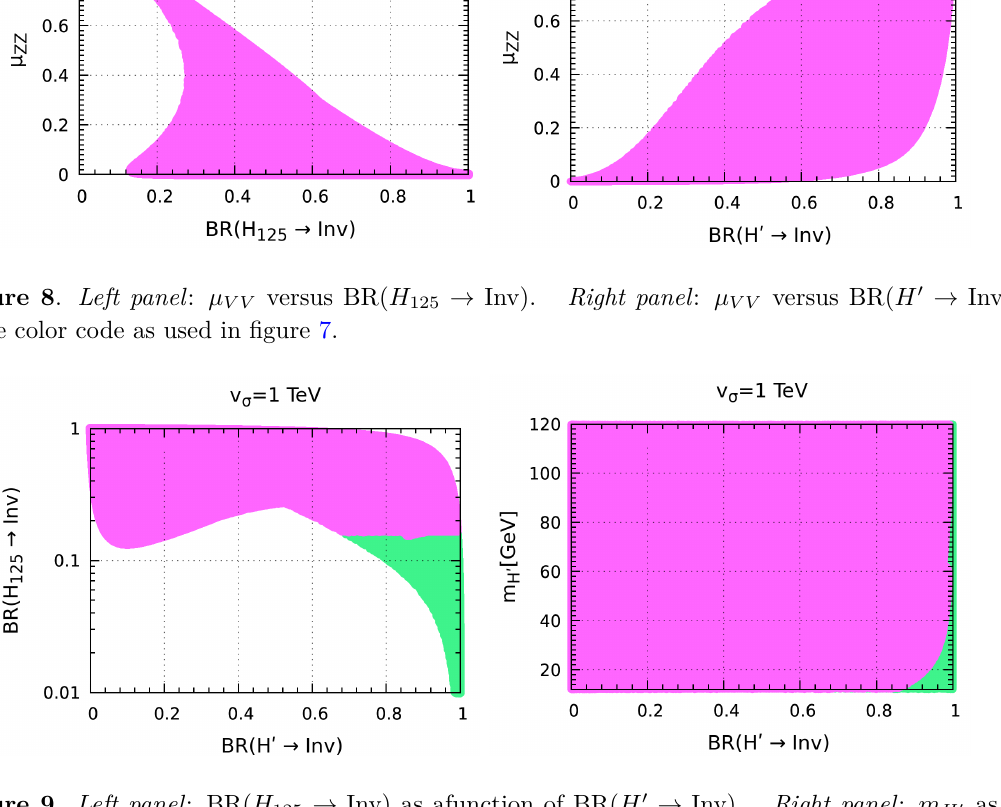
Figure 9 . Left panel : BR ( H 125 → Inv ) as afunction of BR ( H 0 → Inv ) . Right panel : m H 0 as a function of BR ( H 0 → Inv ) . The color codes are as in figure